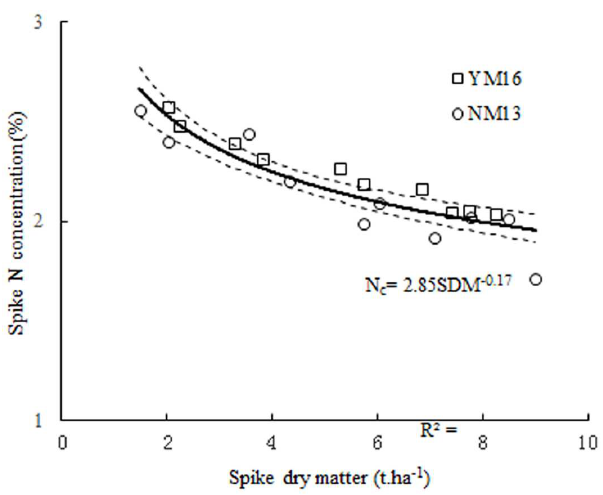
Fig 4. Critical N data points for spike N c curve definition using pooled data from two cultivars. The solid line represents the critical N dilution curve (N c = 2.85 × SDM -0.17 , R 2 = 0.8) that describes the relationship between the N c concentration and SDM of wheat. The dotted lines represent the 95% confidence interval ( P =